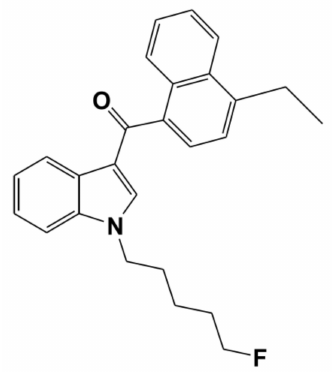
Figure 1. Chemical structure of